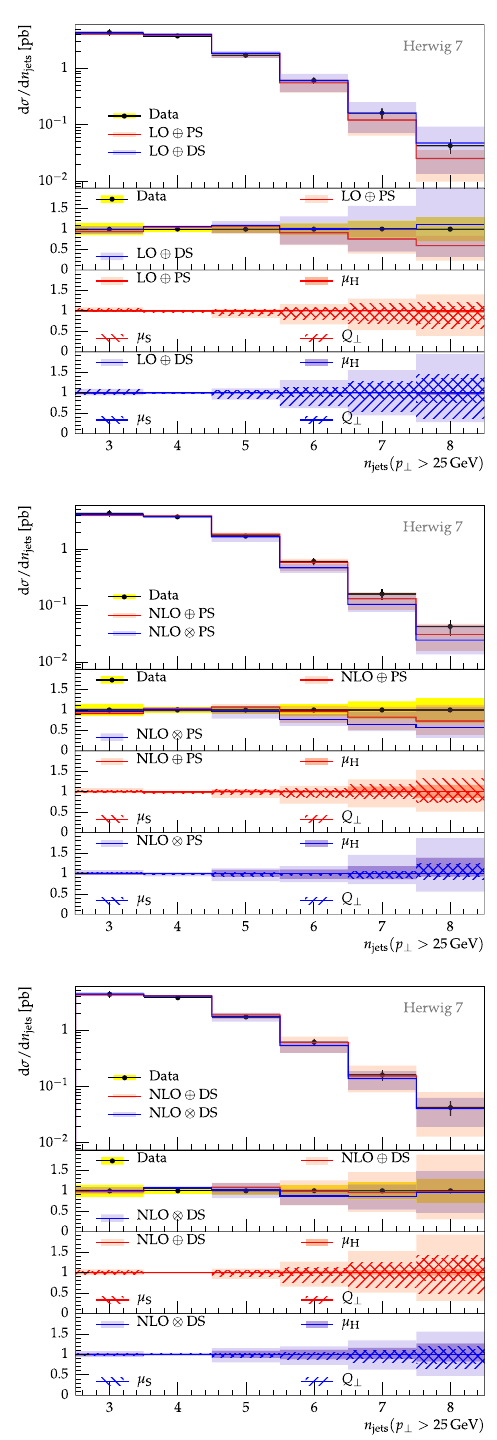
Fig. 10 Themultiplicitydistributionofjetswithtransversemomentum greaterthan25GeV,measuredinsemileptonic7TeV pp → t ¯ t eventsby ATLAS[63].Thetheoreticalpredictionsarethesameasthosedescribed in the caption of Fig.